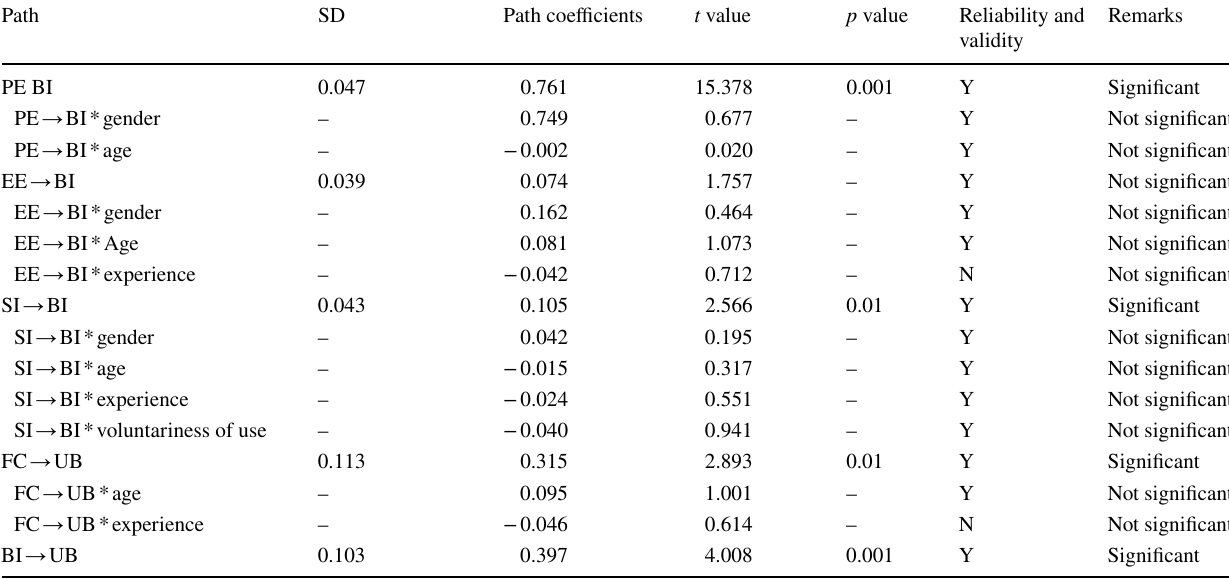
Table 5 PLS final results with and without moderator variables